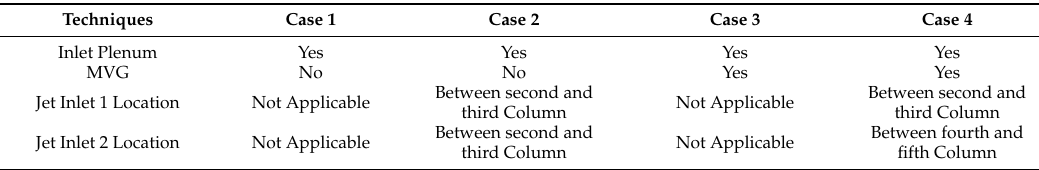
Table 2. Summary of all the battery pack